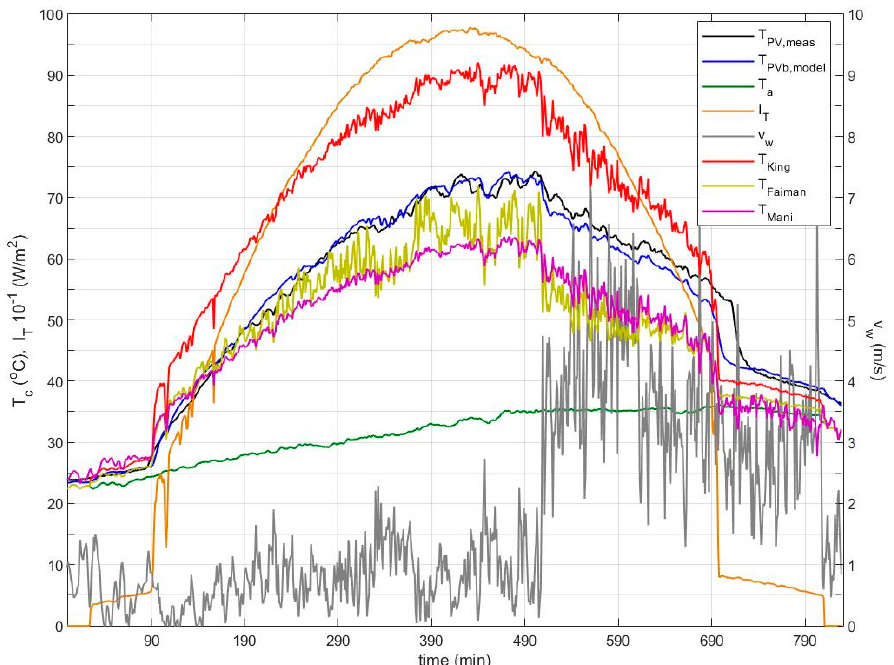
Figure 4. As in Figure 3, including also a comparison with the predicted temperature profiles as generated by using 3 other models.